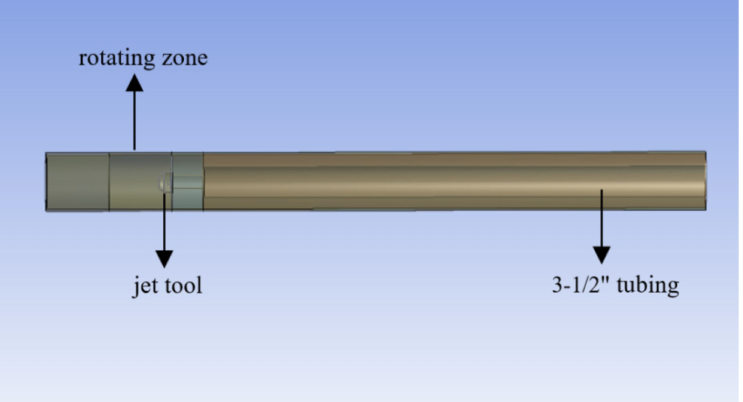
Figure 11. The diagram of the established